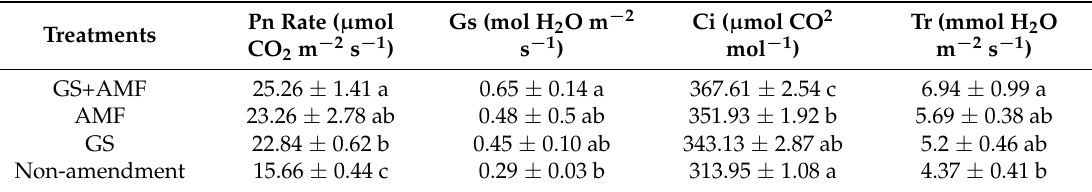
Table 3. Effect of garlic stalk and AMF on photosynthesis and leaf gas exchange measurements of cucumber in